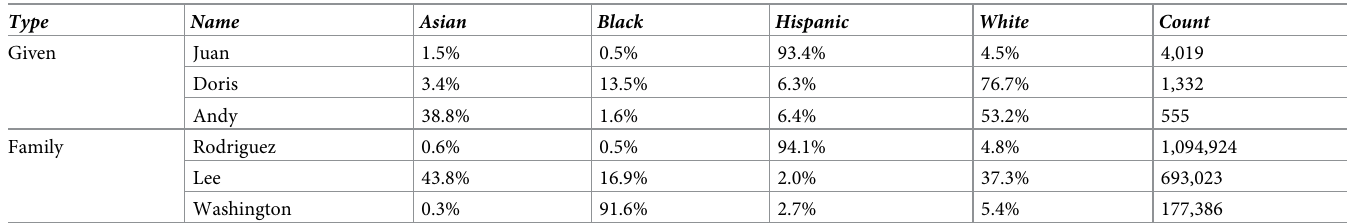
Table 1. Sample of family names (U.S. Census) and given names (mortgage data).